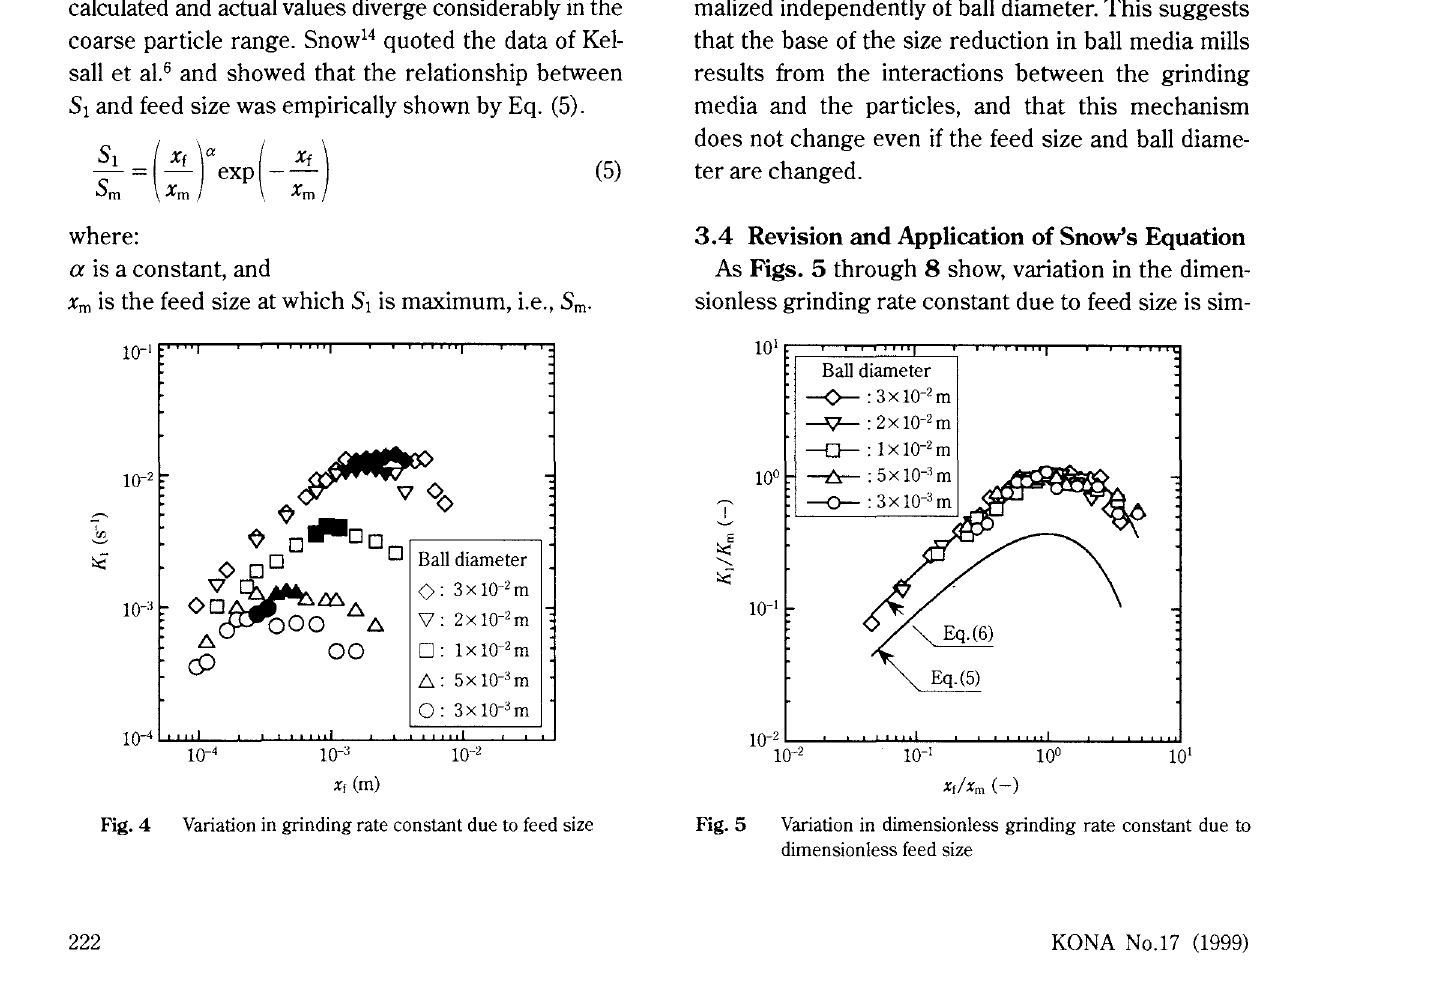
dimensionless feed